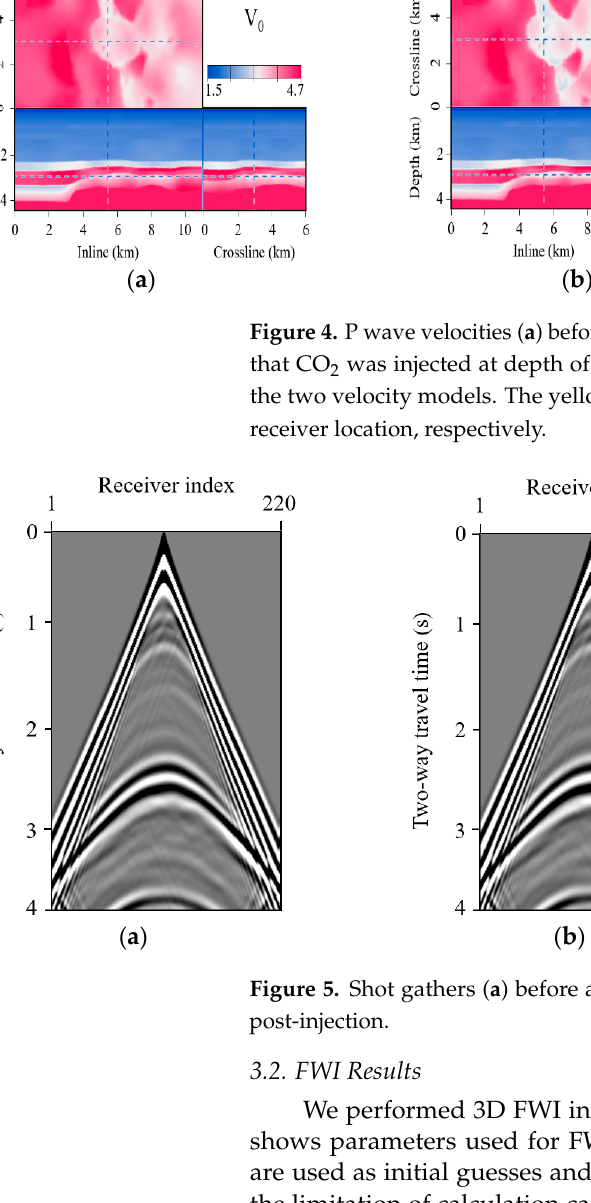
Table 1. Parameter information for FWI and RTM.